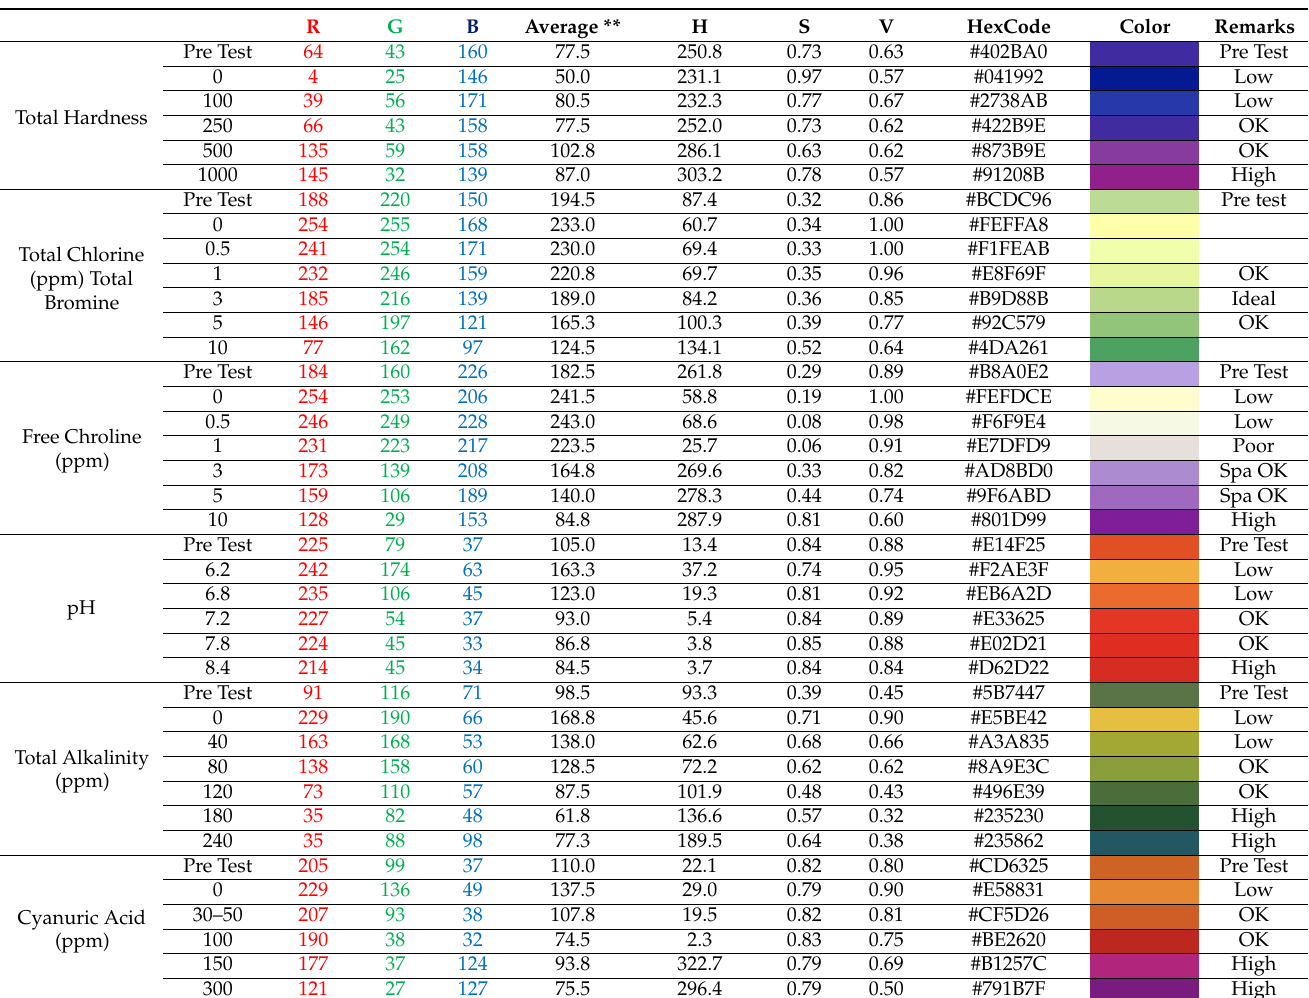
Table 3. Summary of color analysis results of a commercially available AquaChek Color Chart, which indicates the chemical levels in hot tub water [43]. Intensity of red, green and blue channels were shown in representing